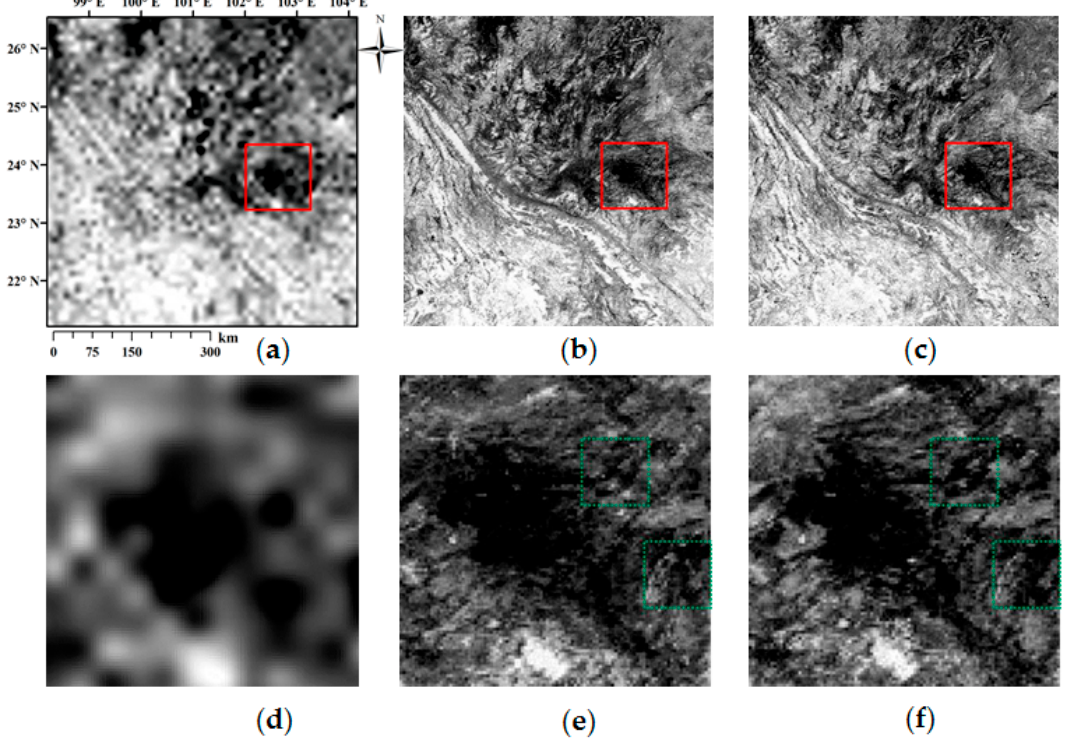
Figure 5. Qualitative comparison of the fusion method for April 2000: ( a ) resampled result of the original MODIS-like NDVI; ( b ) fusion result NDVI fusion ; ( c ) real MODIS data; ( d – f ) are the enlarged display for the part in the red rectangle of ( a – c ), respectively. The green rectangles identify the two areas with differences.